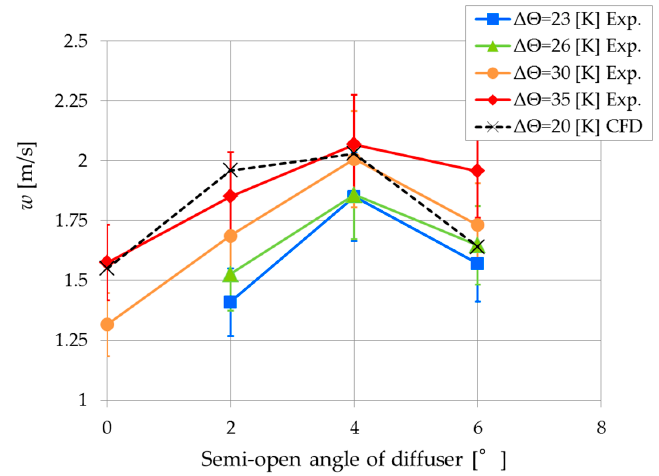
Figure 13. Updraft speed w at height z = 450 mm (the same position as that in the experiments; Figure 5) vs. semi-open angle of the diffuser model with tower height h = 2 m, for each temperature difference ∆ Θ = 20 K (CFD), 23–35 K (experiment).